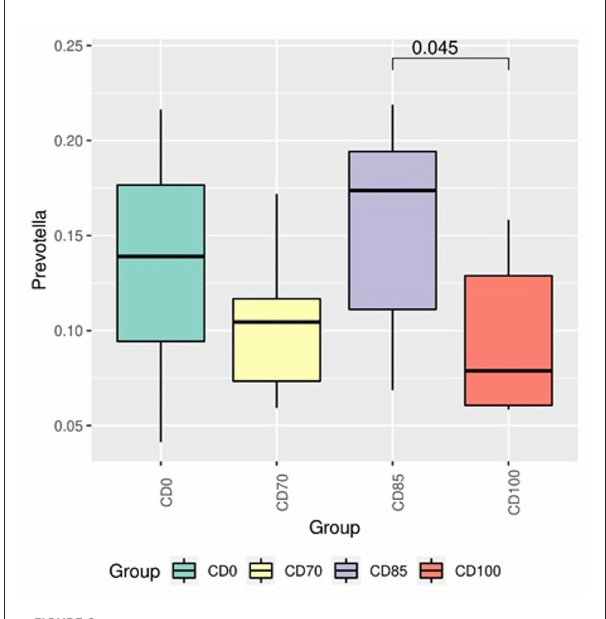
FIGURE5 Differential abundance analysis of taxon of the Muribaculaceae family in finisher pigs fed 1 of 4 dietary treatments: a control diet containing isolated phytase and xylanase valued at 40 kcal of ME/kg (CD0), CD0 + β -mannanase (0.3 g/kg valued at 30 kcal of ME/kg) (CD70), CD0 + β -mannanase (0.3 g/kg valued at 45 kcal of ME/kg) (CD85), and CD0 + β -mannanase (0.3 g/kg valued at 60 kcal of ME/kg) (CD100). Data are averages of 6 pigs per dietary treatment. Means differed by Wilcoxon test ( P < 0.05).